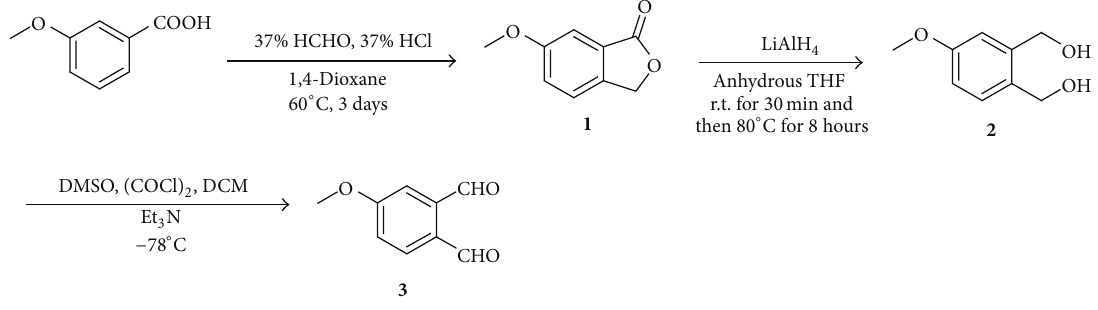
Figure 1: Synthetic route of